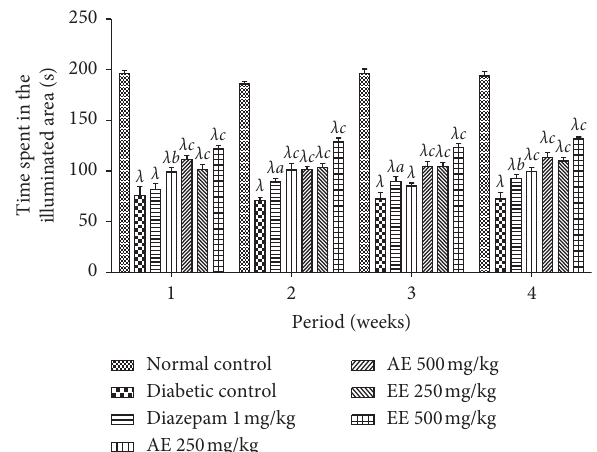
Figure 9: Effects of the aqueous (AE) and ethanol (EE) extracts of Dissotis thollonii on the absolute time spent in the open arms (light) compartment during 5min of exposure to the light-dark box test. Values are expressed as mean ± SEM for six animals and analyzed by two-way ANOVA followed by Bonferroni post hoc test. λ p < 0 . 001 when compared with the normal control and a p < 0 . 05, b p < 0 . 01, c p < 0 . 001 when compared with the diabetic control; s: seconds.